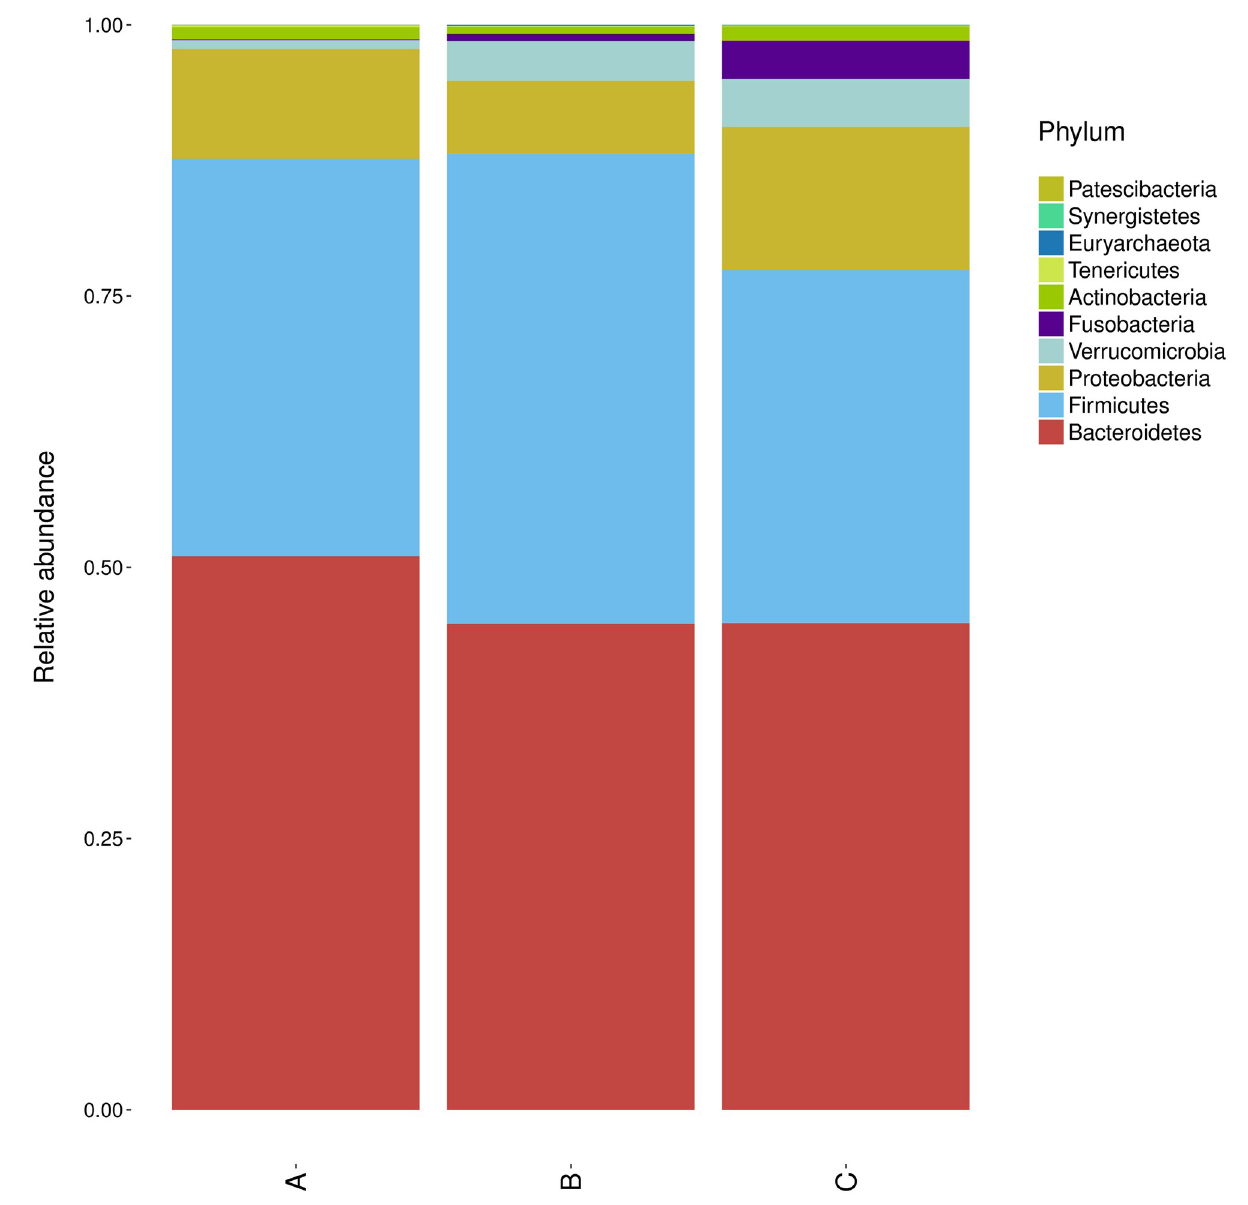
Fig 2. Phylum abundance of each groups. A: stage 1, B: stage 2, C: stage 3+4.